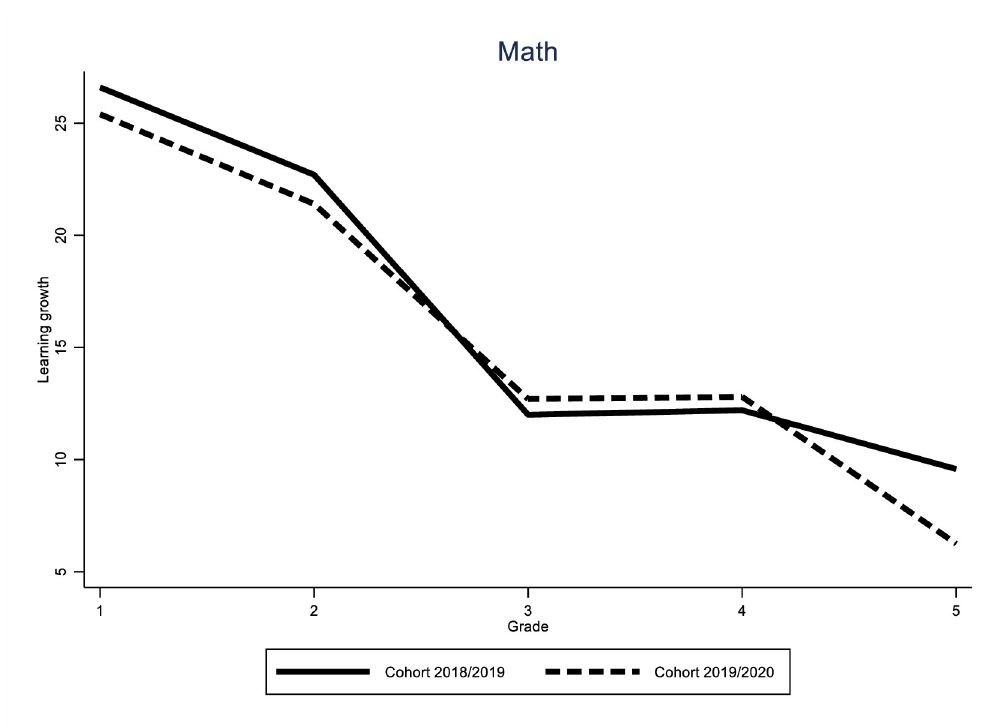
Fig 10. Learning gain: Grade 5 students of 2018/2019 compared to Grade 5 students of 2019/2020 –math.